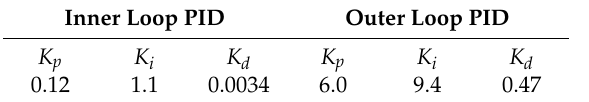
Table 4. The PID controller parameters.